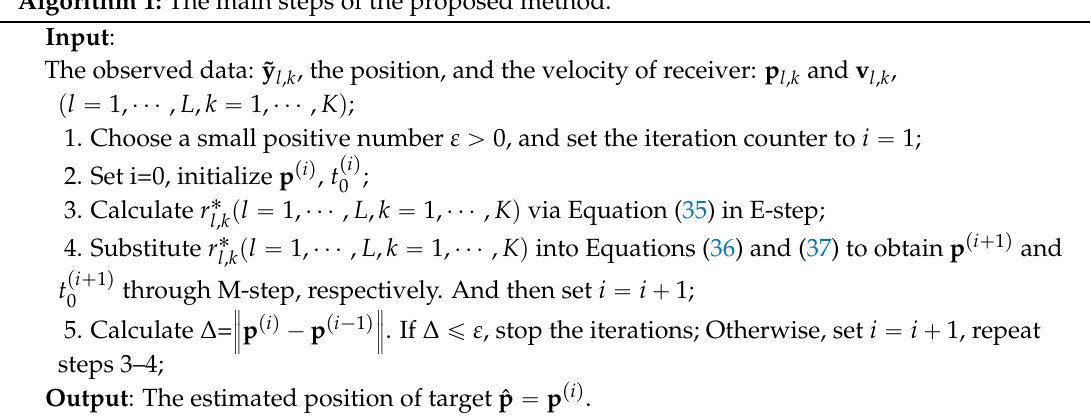
Algorithm 1: The main steps of the proposed method.